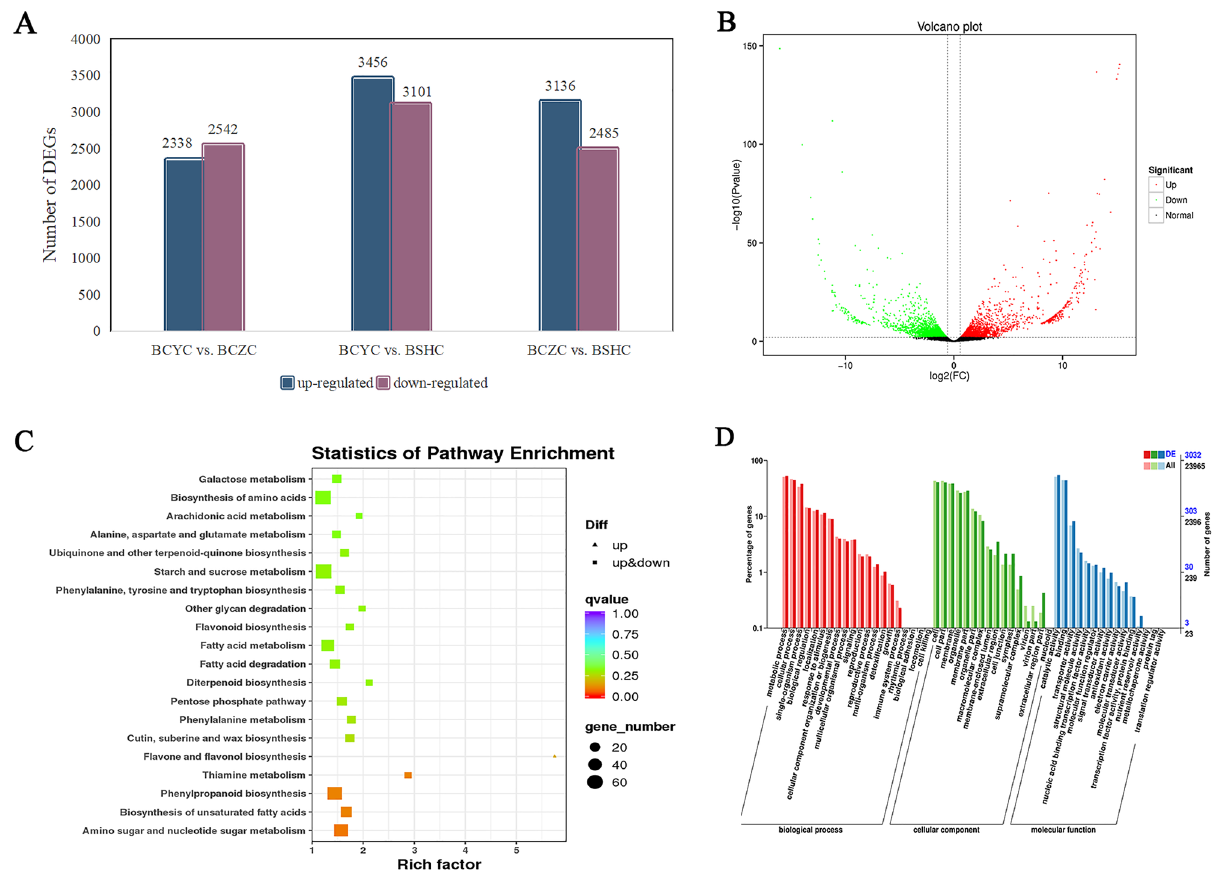
Figure 4. Correlation diagram of DEGs. ( A ) Statistical analysis of up- and down-regulation of DEGs in each group. ( B ) Volcano plot of DEGs (BCYC vs. BCZC). ( C ) Scatter plot of DEGs KEGG pathway enrichment (BCYC vs. BCZC). Each dot represents a KEGG pathway. The ordinate represents the name of the pathway, and the abscissa is the enrichment factor. A greater enrichment factor indicates a more significant enrichment level of DEGs in this pathway. The size of dots represents the number of DEGs enriched in the pathway. ( D ) GO enrichment analysis of DEGs (BCYC vs. BCZC).